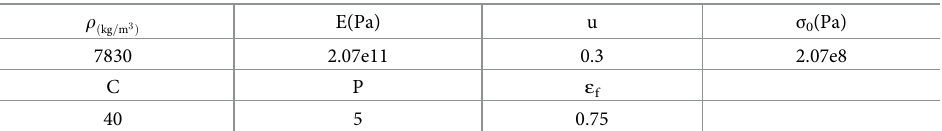
Table 1. Material model parameters of metal plate.